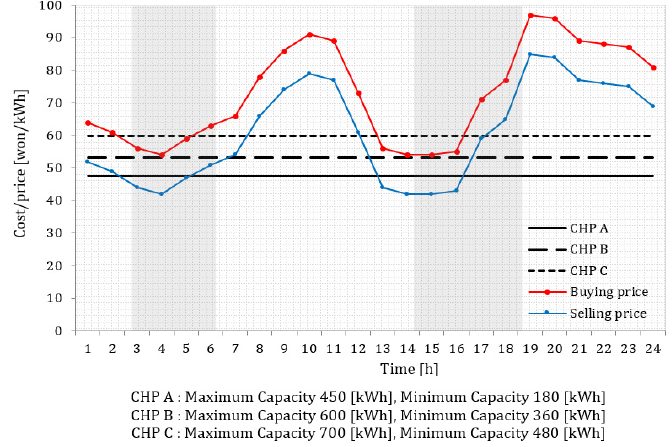
Figure 9. External trading prices compared with production costs of CHP generators.